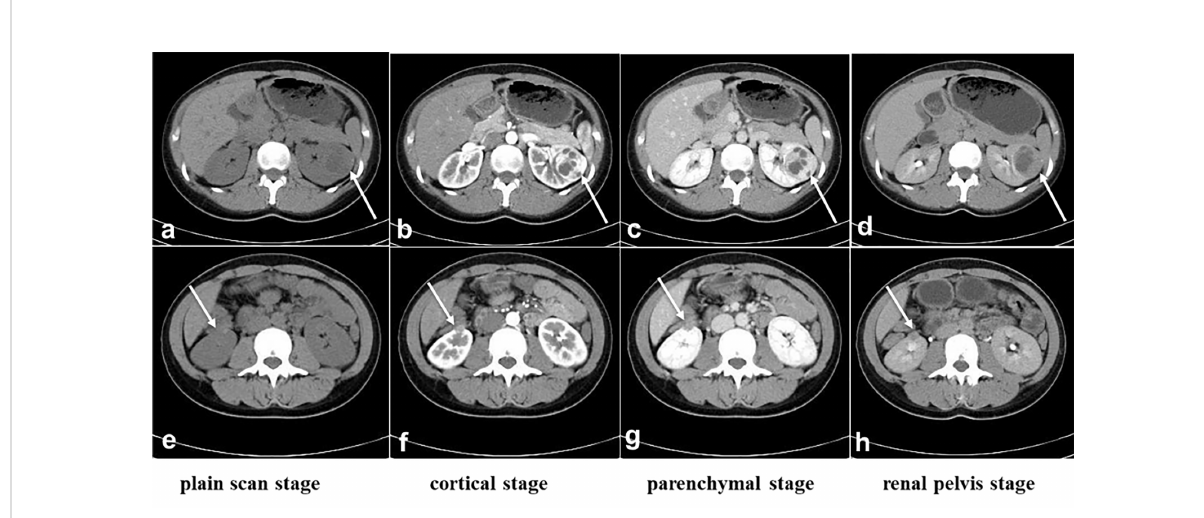
FIGURE 1 CT before surgery. (A-D) : The location and size of the tumor in the left kidney. (E, F) : The location and size of the tumor in the right kidney. (A) and (E) : Plain scan stage, (B, F) : cortical stage, (C, G) : parenchymal stage, (D, H) : renal pelvis stage. The white arrow indicates the